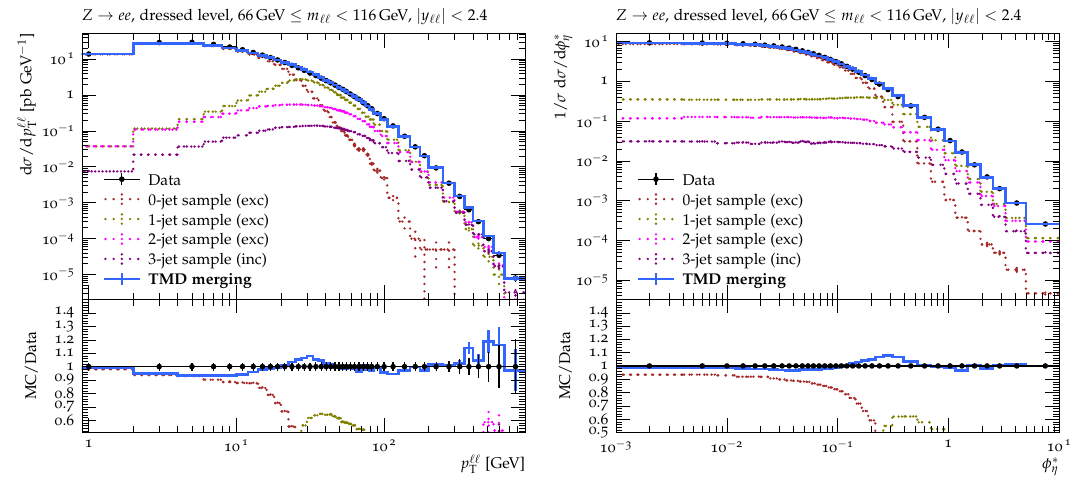
Figure 9 . Transverse momentum p T spectrum (left) and φ ∗ normalized distribution (right) of DY lepton pairs from Z -boson decays. Experimental measurements by ATLAS [60] at are compared to predictions using the TMD merging calculation. Separate contributions from the different jet samples are shown. All jet multiplicities are obtained in exclusive (exc) mode except for the highest multiplicity which is calculated in inclusive (inc)